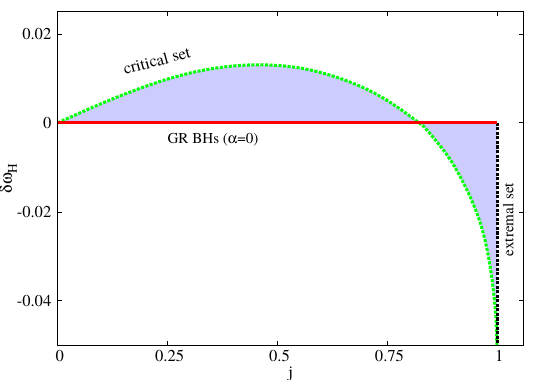
Figure 7 . Reduced horizon angular velocity di(cid:11)erence between EsGB BHs and Kerr BHs in a (cid:14)! H vs. j plot. For small j the di(cid:11)erence is positive, meaning that EsGB BHs spin faster. But for large j the di(cid:11)erence is negative, meaning that EsGB BHs spin slower. in (cid:12)gure 6 (left and right panels). One may interpret these behaviours as a